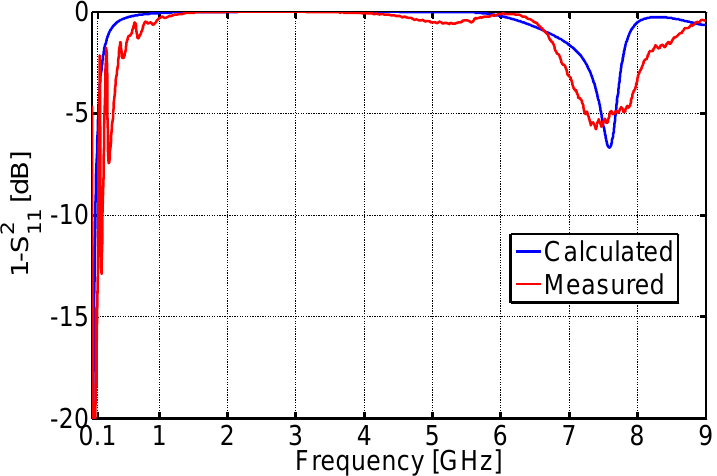
Figure 18. Detailed view of the measured transmission coefficient within operating frequency range .